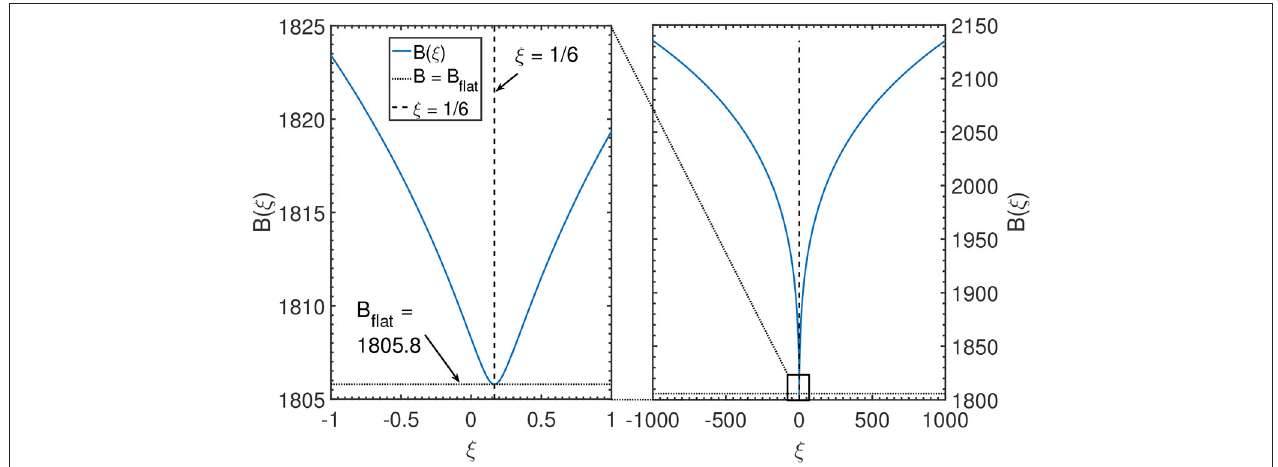
FIGURE 5 | Plot of the decay rate for a flat false vacuum for different values of the non-minimal coupling, ξ . The minimal action is obtained close to the conformal value ξ 1 / 6, and agrees well with the flat space result (4.24). Originally published in Rajantie and Stopyra (2017). =